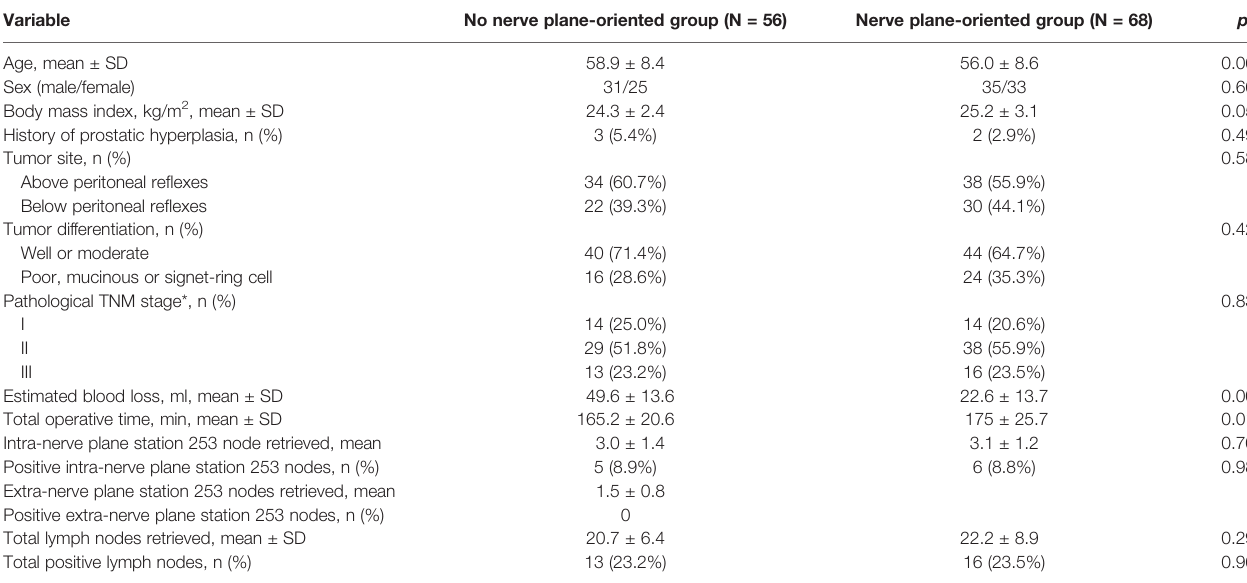
TABLE 1 | Clinical and pathological characteristics of participating patients.